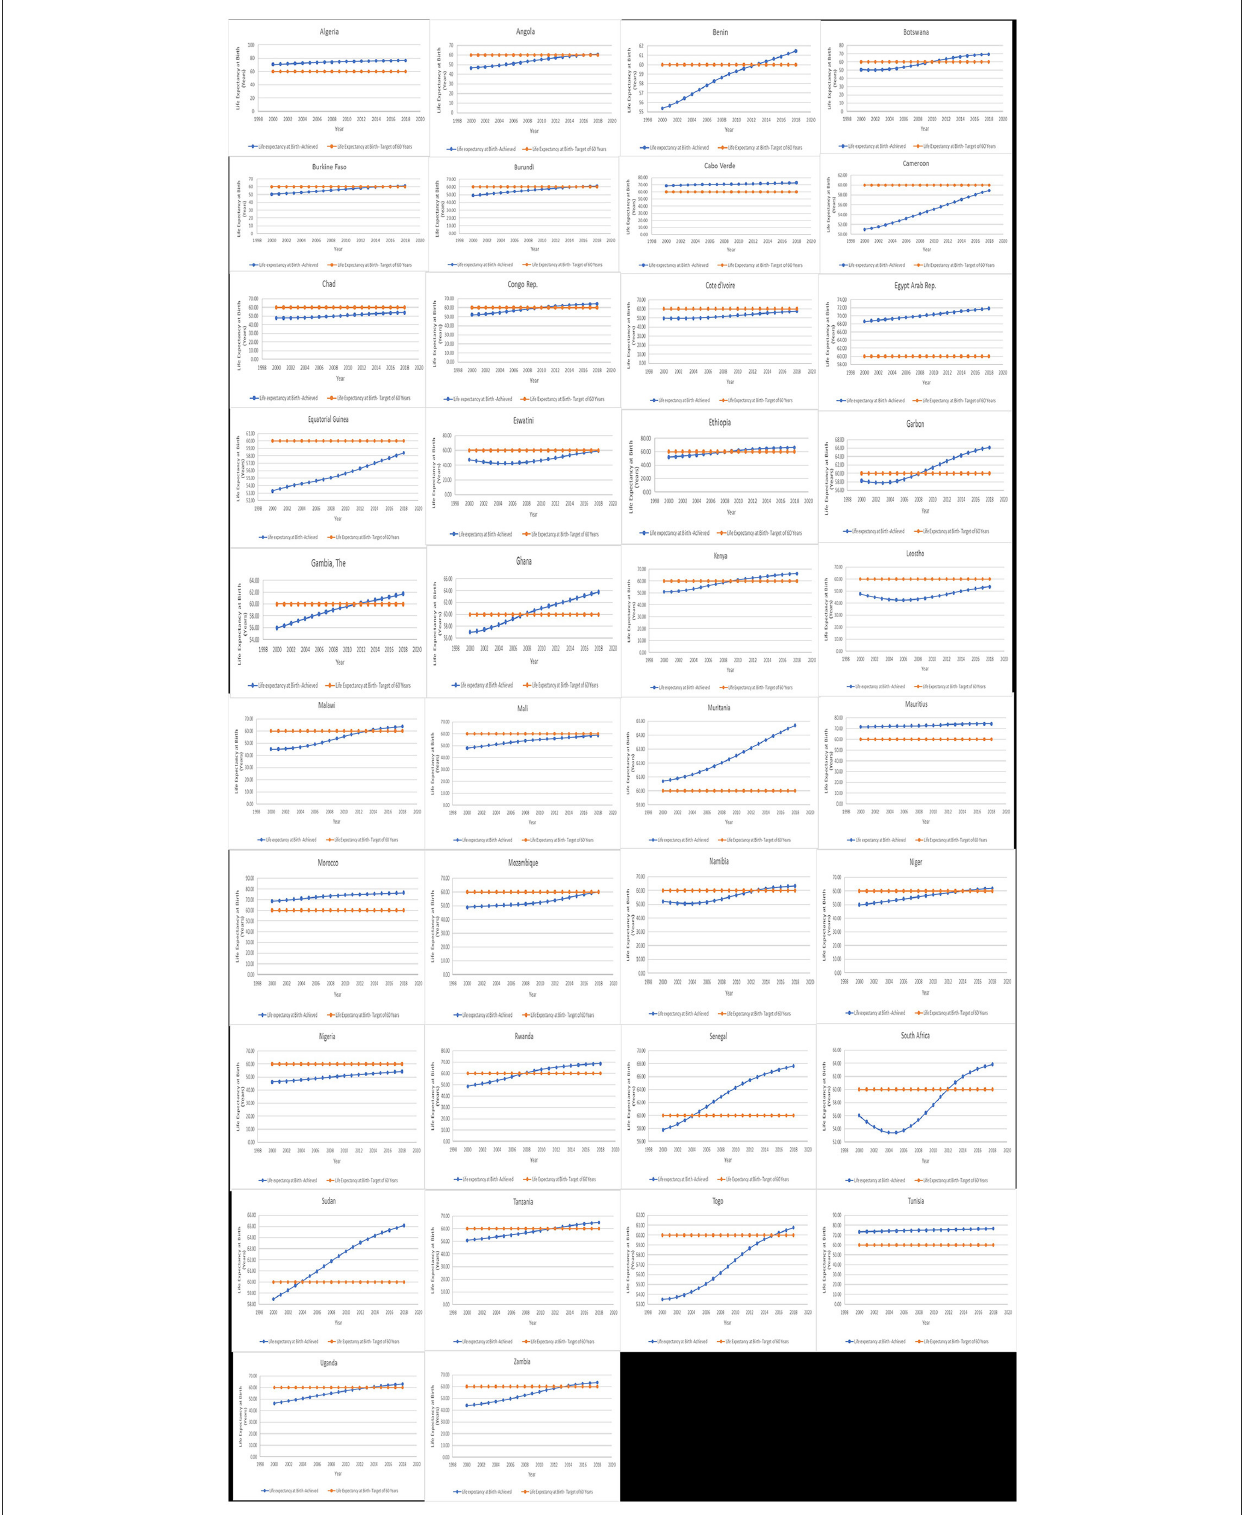
FIGURE4 Trend in life expectancy at birth target (60 years) vs. life expectancy at birth achieved by the country. Source: Data used for the graph was obtained from the World